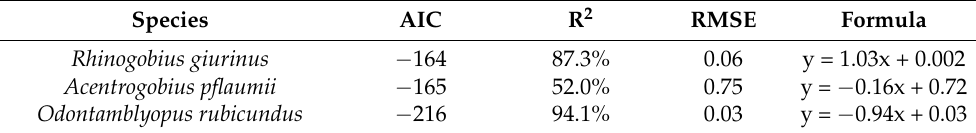
Table 4. Optimal model parameters and their formulas obtained from